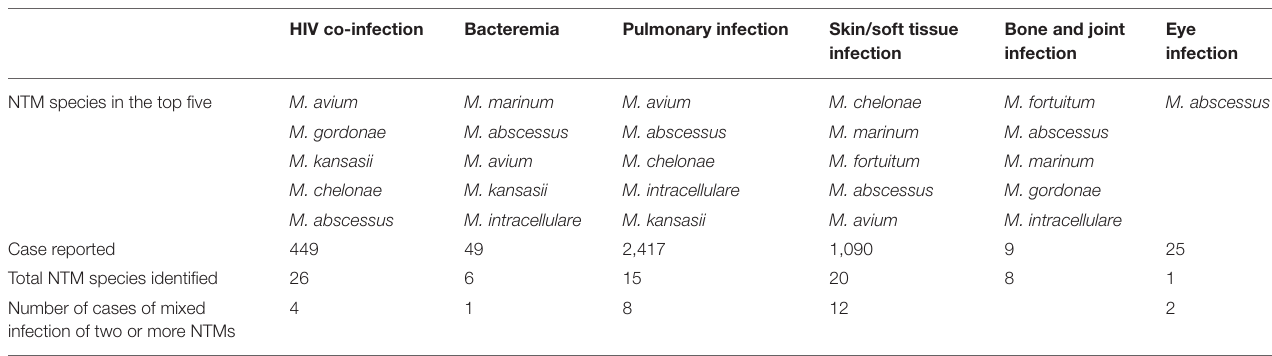
HIV co-infection Bacteremia Pulmonary infection Skin/soft tissue